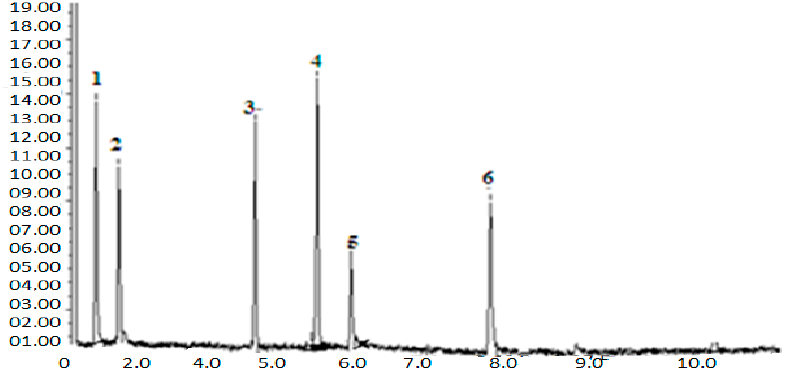
Figure 2. Chromatogram of VOCs detected from recovery test. 1-carbontetrachloride, 2-chloroform, toluene, 4-styrene, 5-bromoform, 6-dibromomethane, 7-is-1,3-dichloropropane, 8-trans-1,3-dichloropropane, and 9-O-xylene.